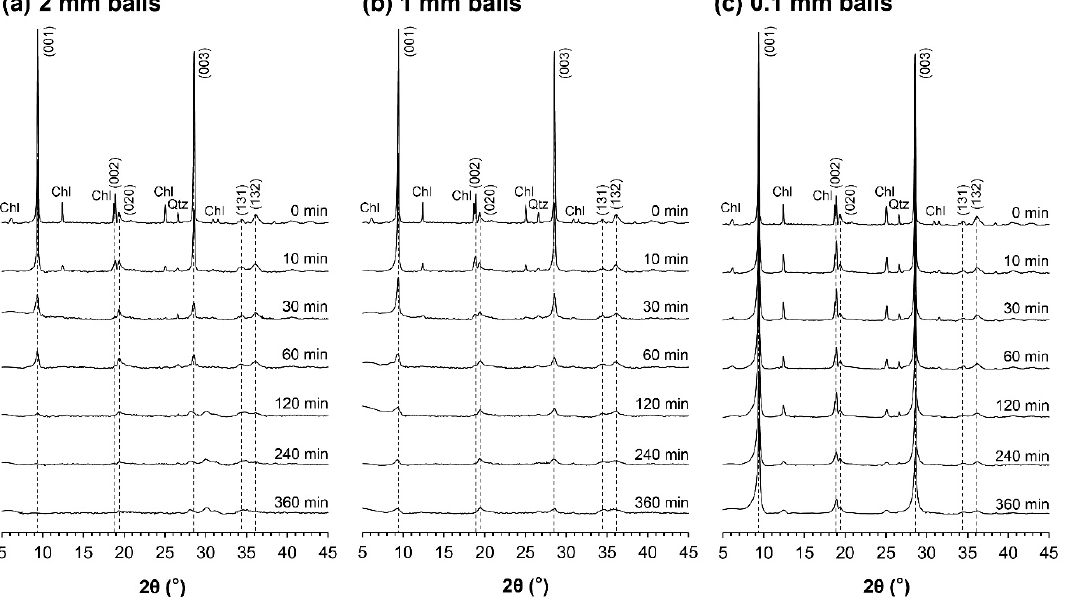
Figure 2. XRD patterns of talc powder upon grinding with ( a ) 2 mm, ( b ) 1 mm, and ( c ) 0.1 mm balls. Chl: chlorite, Qtz: